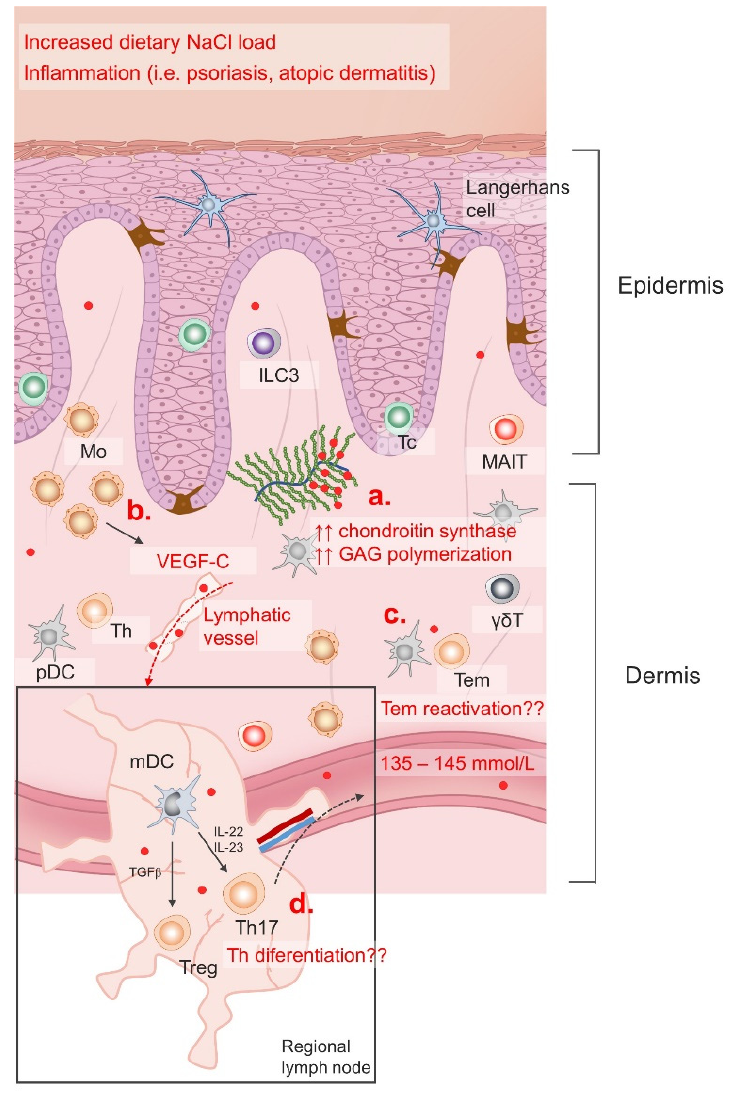
Figure 2. Regulation of skin NaCl storage. Serum NaCl (red dots) concentration is maintained within a narrow range (135–145 mm/L) with varying dietary intake and in different pathological conditions; however, recent data suggests that the skin NaCl content changes significantly in response to dietary load and inflammation. Increased GAG polymerization (a) enables Na+ storage, while neo(lympho)angiogenesis allows NaCl clearance in the skin induced by VEGF-C stimuli (b). Skin is an important lymphoid compartment characterized by immune surveillance cells. Increased Na+ content affects Tem reactivation (c) in the skin, as well as naïve Th lymphocytes differentiation in the regional lymph nodes (d). Mo, monocytes; ILC3, innate lymphoid cell 3; Tc, cytotoxic T cell; MAIT, mucosa as- sociated invariant T cell; pDC, plasmacytoid dendritic cell; mDC, myeloid dendritic cell; Treg, regulatory T cell; Th, T helper cell; Tem, effector memory T cell; GAG, glycosamino- glycans; VEGF-C, vascular endothelial growth factor C; IL, interleukin; TGF β , transform- ing growth factor beta; γδ T, gamma delta ( γδ ) T cells. Moreover, this mechanism seems to be important for blood pressure regulation dur- ing acute salt loading, since in an experimental animal model, VEGF-C receptor blockade led to an immediate blood pressure increase [165,185]. This is further corroborated by the finding of increased sodium content in the skin of patients with hypertension [186]. In the case of psoriasis, a prototypical TNF α –Th17 disease model, recent data demon- strated increased sodium and water retention in lesional and non-lesional skin, but only in patients with a moderate to severe form of the disease (PASI > 5), and not in those with a mild form (PASI < 5). Sodium accumulation correlated to the disease severity and fre- quencies of peripheral blood IL-17-secreting ɣ δ T cells [16]. Consistent with previous re- ports, the authors of the same study reported increased IL-17A production from naïve CD4 T cells primed under Th17-polarizing cytokines and high NaCl concentrations.